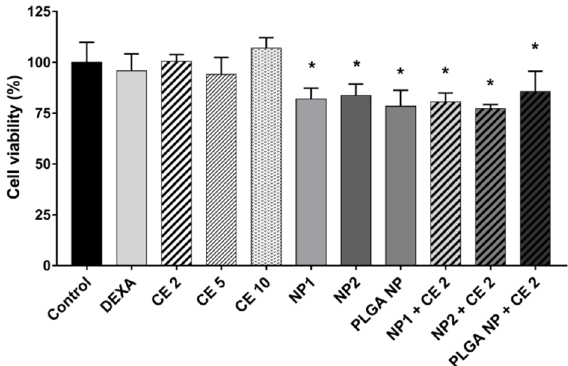
Figure 1. Cell viability. Human umbilical vein endothelial cells (HUVEC) were treated with different cherry extract (CE) polyphenols concentrations (2, 5, 10 µg gallic acid equivalents (GAE)/mL) for 2 h and with empty or CE-loaded NPs (NP1: QA-Ch-NP; NP2: QA-Ch-S-pro-NP; and PLGA NPs) with 2 µg GAE/mL of CE (CE 2) or dexamethasone (DEXA) (5 µg/mL) for 2 h. Data are the means ± standard deviation (SD) of three independent experiments. * p < 0.05 vs. Control (untreated cells).